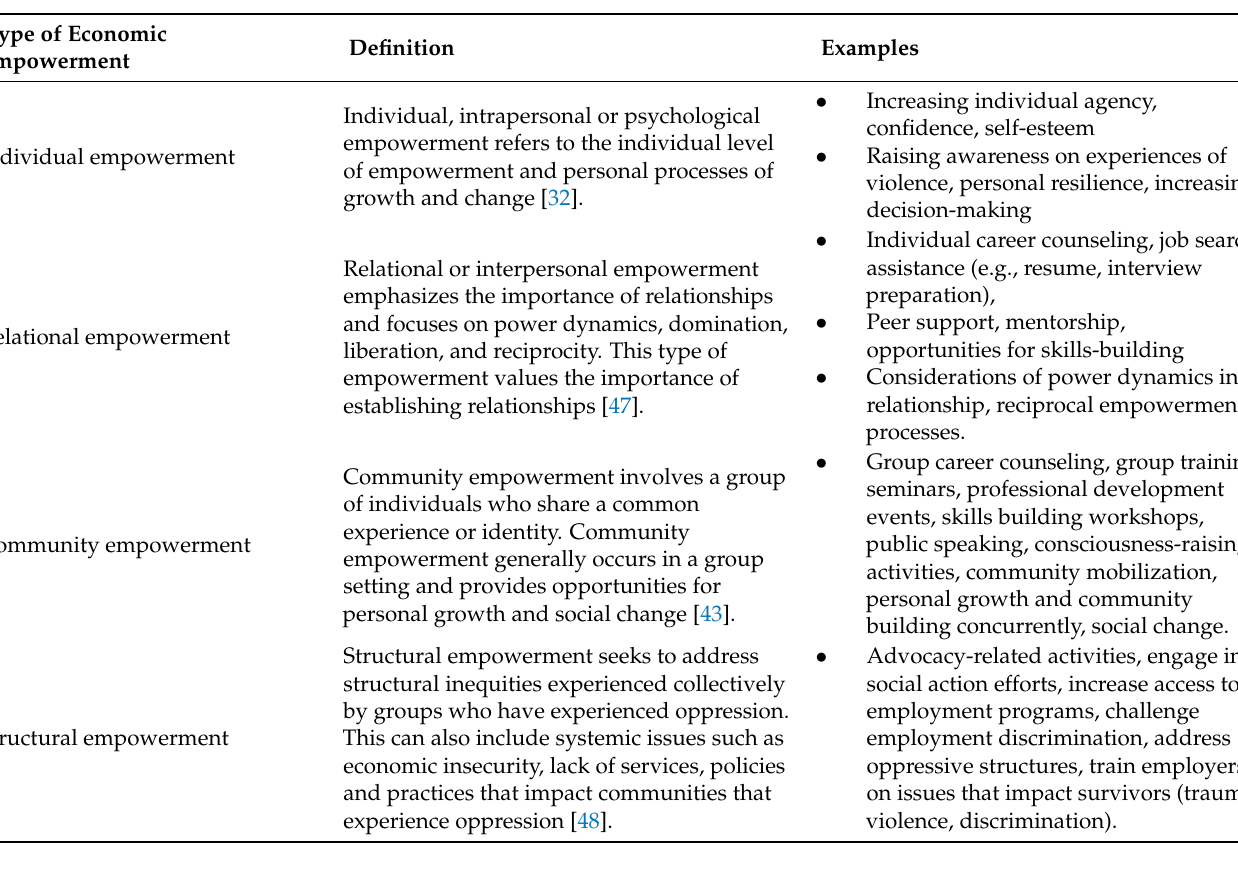
Table 2. Economic empowerment practice examples for employment-seeking survivors of intimate partner violence